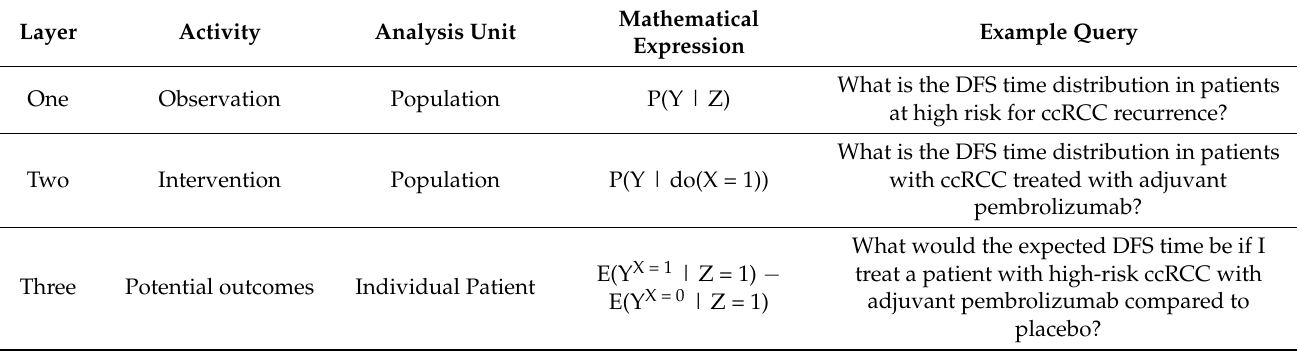
Table 2. The ladder of causation [40]. Y is the outcome, DFS time; X is treatment, with X = 1 for adjuvant pembrolizumab and X = 0 for placebo; Z is the baseline prognostic risk, with Z = 1 for high risk of recurrence. ccRCC = clear cell renal